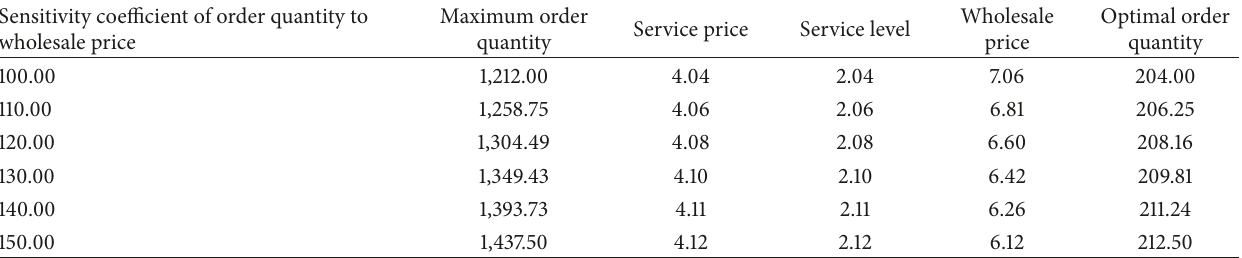
Table 3: The effect of the sensitivity coefficient of the order quantity to the wholesale price on the supply chain members’ decisions. Sensitivity coefficient of order quantity to